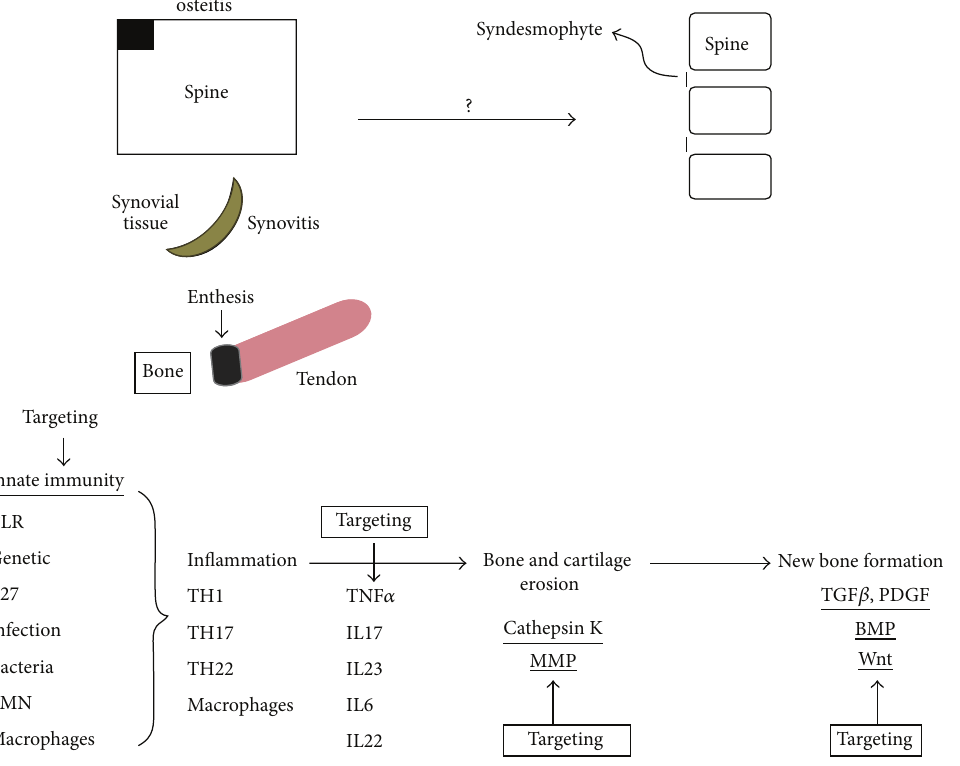
Figure 1: SpA: immunopathogenesis and the potential sites for targeting